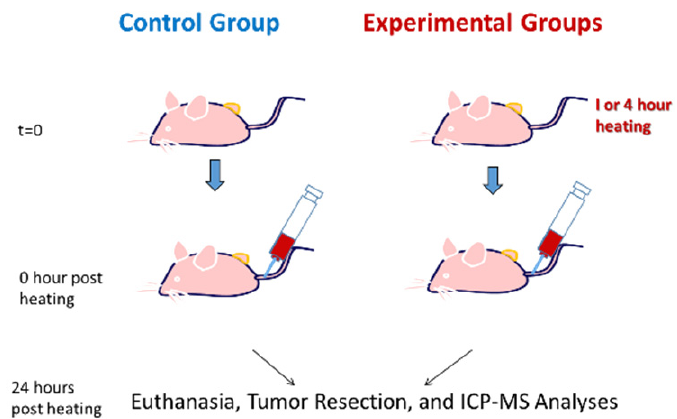
Figure 2. Schematic diagram of the experimental protocol.